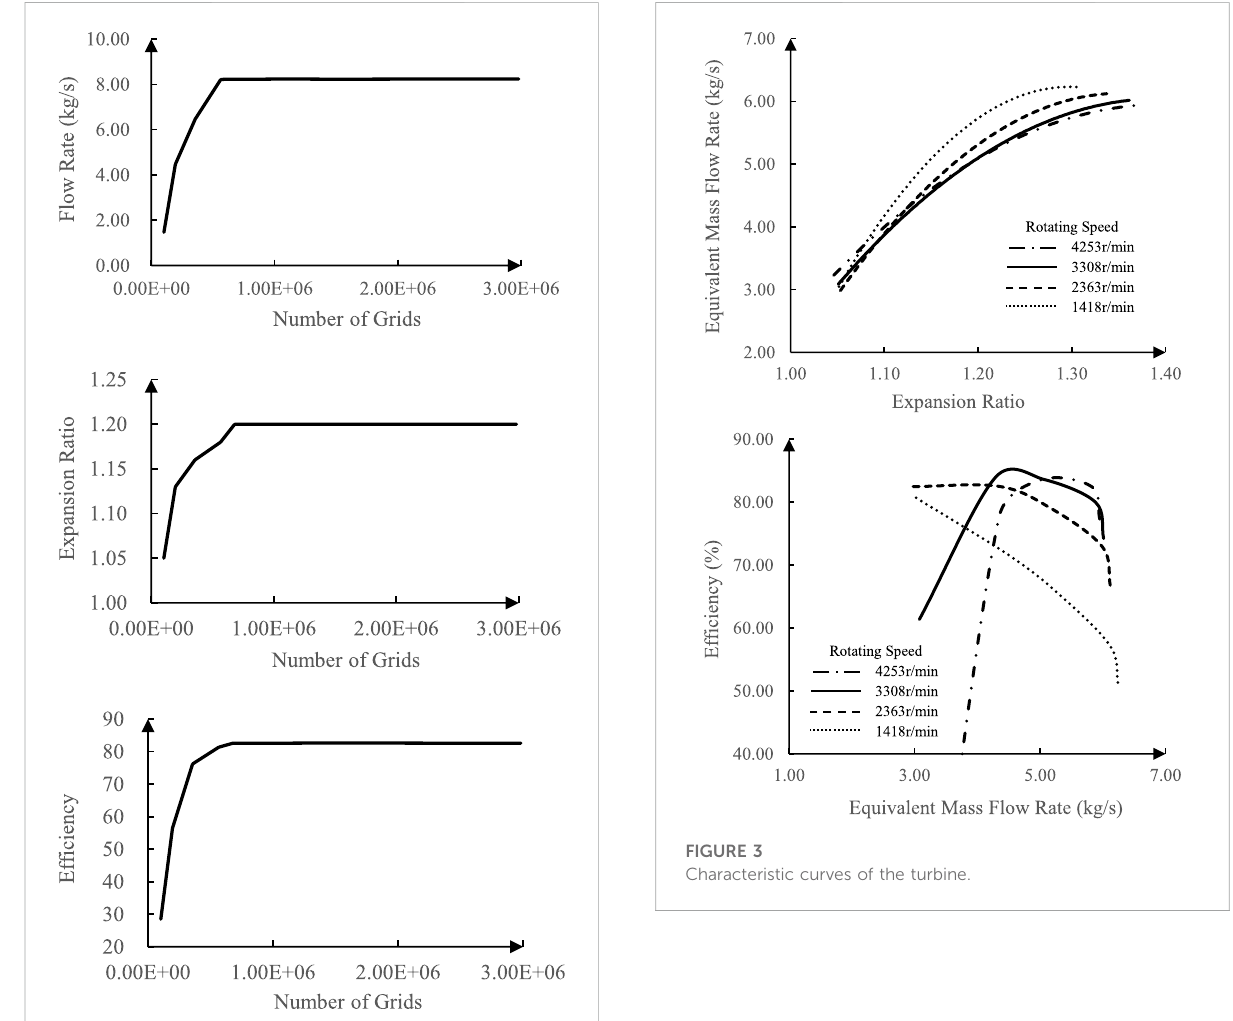
FIGURE 2 The mesh independence study in the design condition.